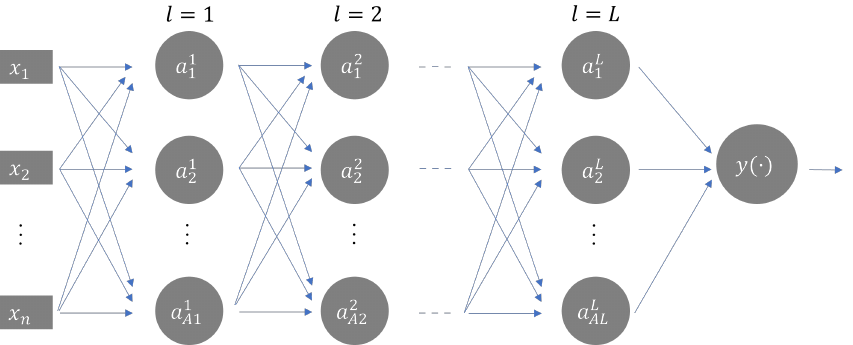
Figure 3. Feed-forward neural network